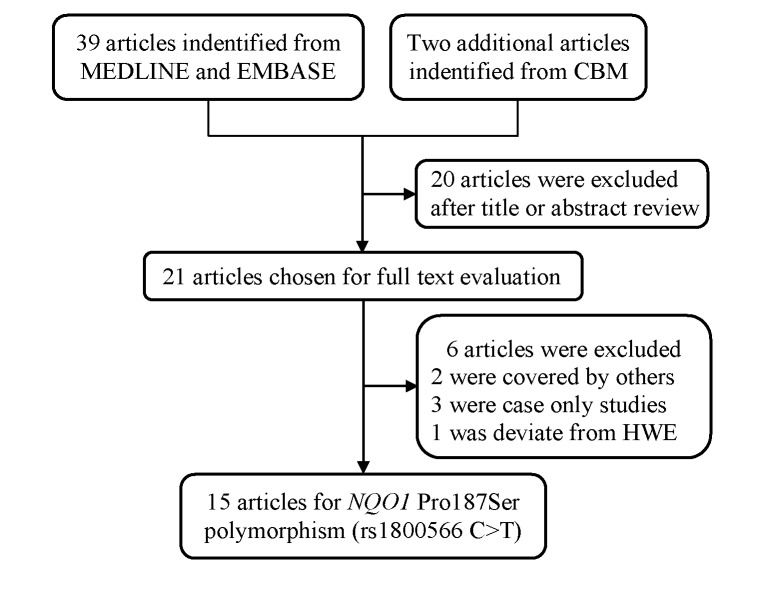
Flow chart of included studies for the association between NQO1 Pro187Ser polymorphism.